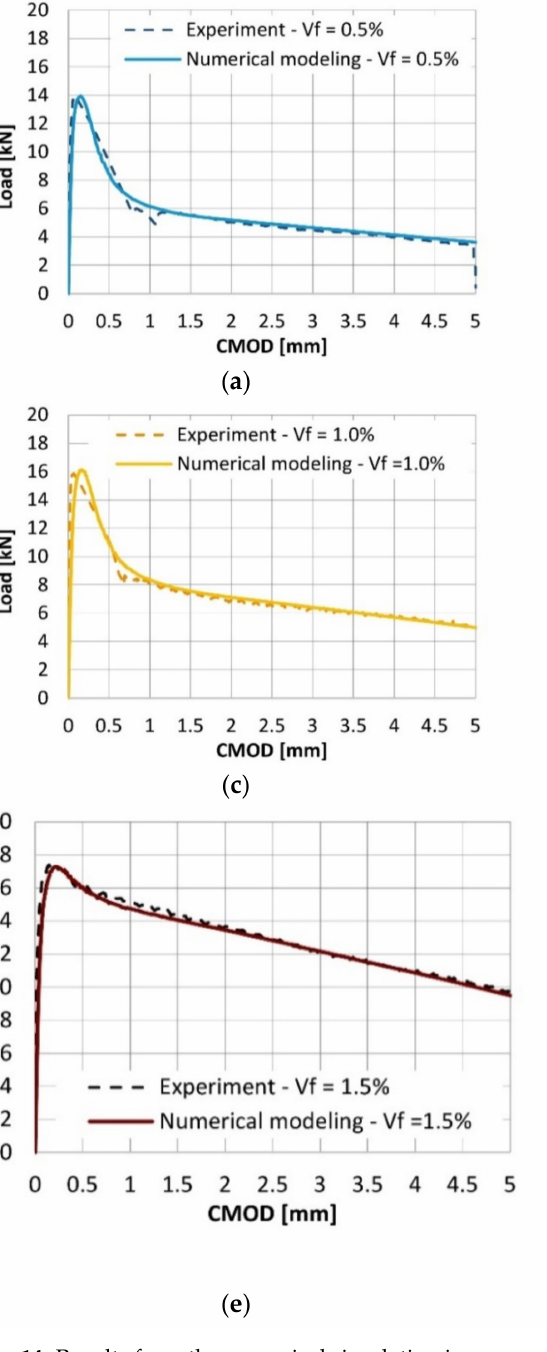
Figure 14. Results from the numerical simulation in comparison to the laboratory investigation of beams reinforced with fiber volume ratio equal to ( a ) 0.5%; ( b ) 0.75%; ( c ) 1.0%; ( d ) 1.25%; and ( e ) 1.5%. ( f ) Collation of the